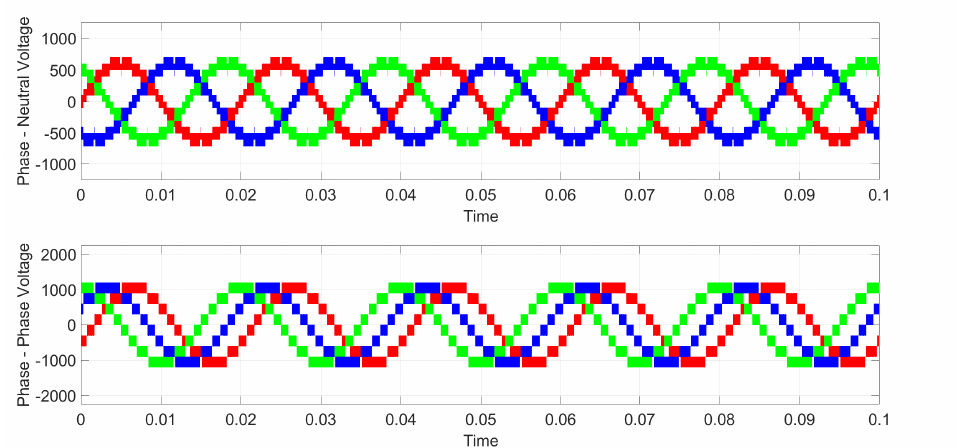
Figure 11. Three-phase output voltage